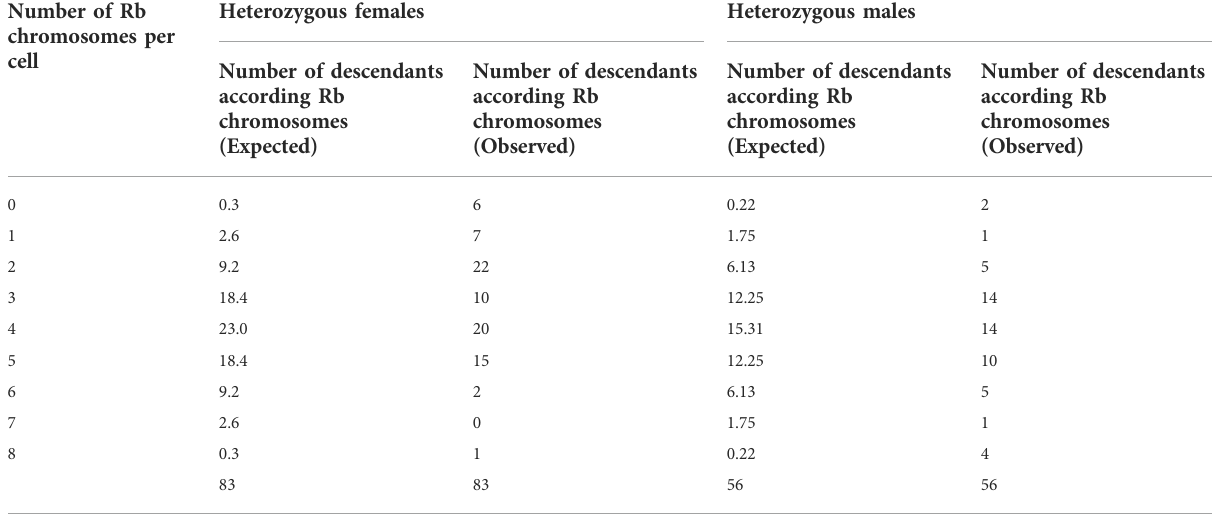
TABLE 3 Observed number of descendants by inherited Rb chromosome and expected frequencies according to the binomial distribution. Heterozygous females ( p -value = 0.0000); Heterozygous males ( p -value = 0.0000).